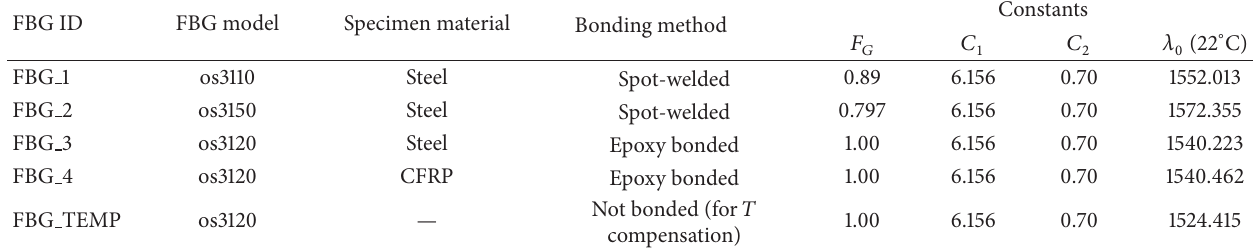
Table 1: Parameters of the FBG sensors.